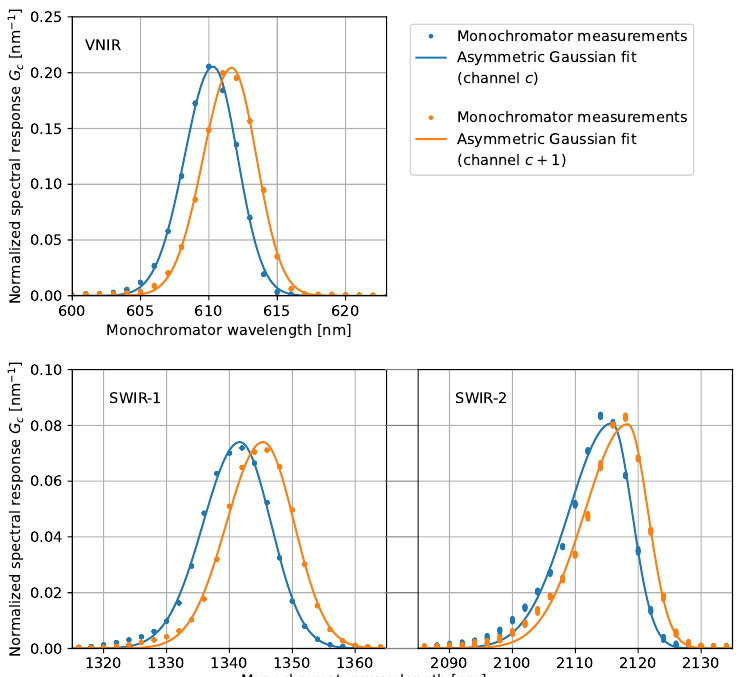
Figure 2. Normalized spectral response functions of two adjacent channels in each of the spectrora- diometer detector arrays with asymmetric Gaussian fits. The plotted channel c is number 190, 610 and 850 for the VNIR, SWIR-1, and SWIR-2 detector, respectively. The asymmetry of the SRF is most pronounced in the SWIR-2 channels.